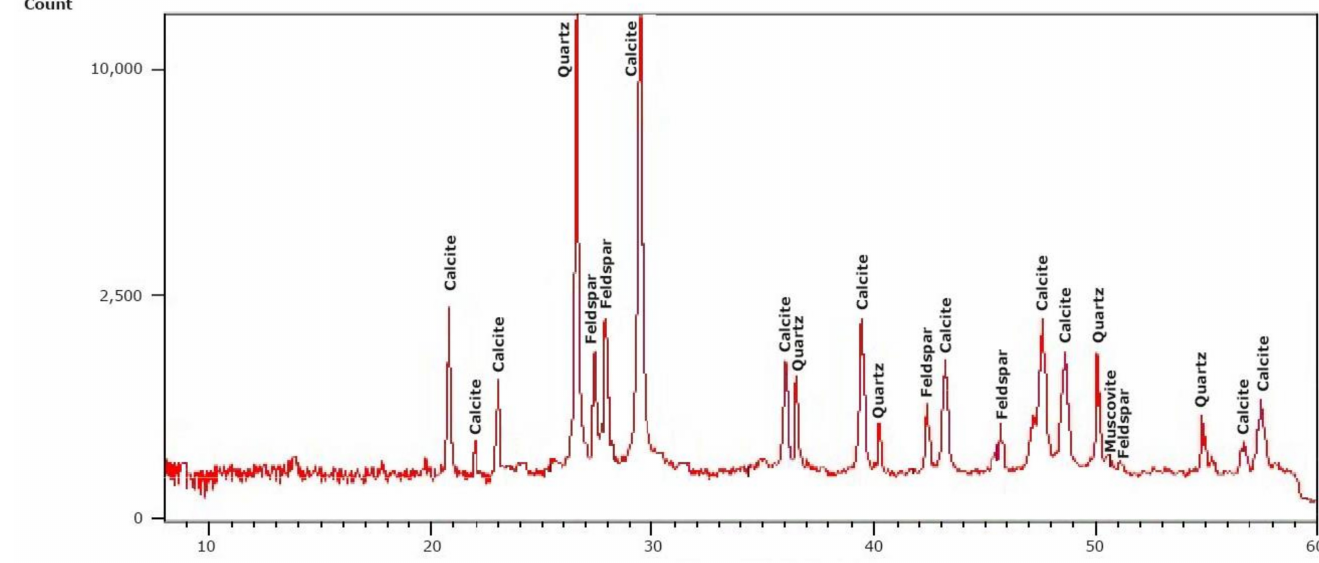
Figure 4. Diffractometry on the